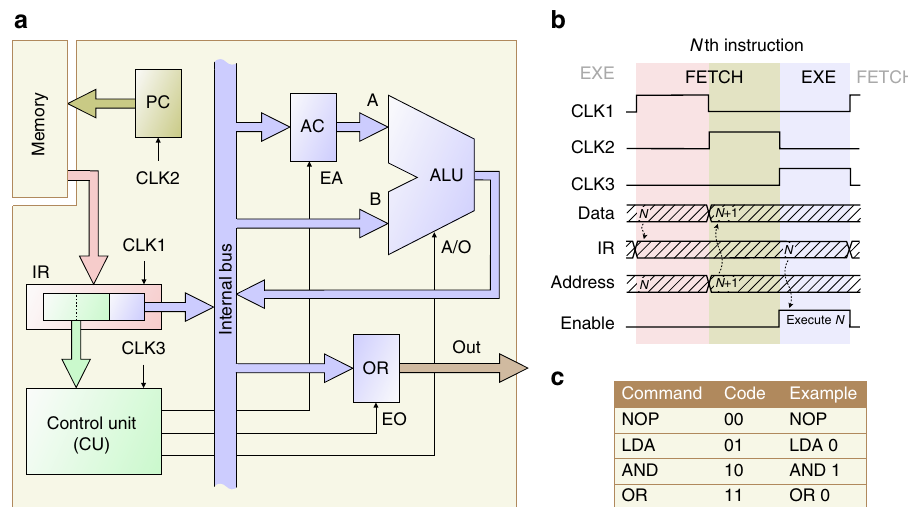
Figure 1 | Microprocessor architecture. ( a ) Block diagram, showing the arithmetic logic unit (ALU) with inputs A and B, accumulator (AC), control unit (CU), instruction register (IR), output register (OR) and program counter (PC). Enable signals (EA and EO) and operation selection code (A/O) are supplied by the CU to the respective subunits. CLK signal generation and memory are implemented off-chip. ( b ) Timing diagram for the N th instruction cycle. During the FETCH sequence the content of the memory is loaded into the IR and the address, stored in the PC, is increased. During the EXE sequence the command, stored in the IR, is executed. ( c ) Instruction set of the microprocessor. NOP is the no-operation instruction; LDA transfers data from the memory into the AC; AND and OR perform logical operations.